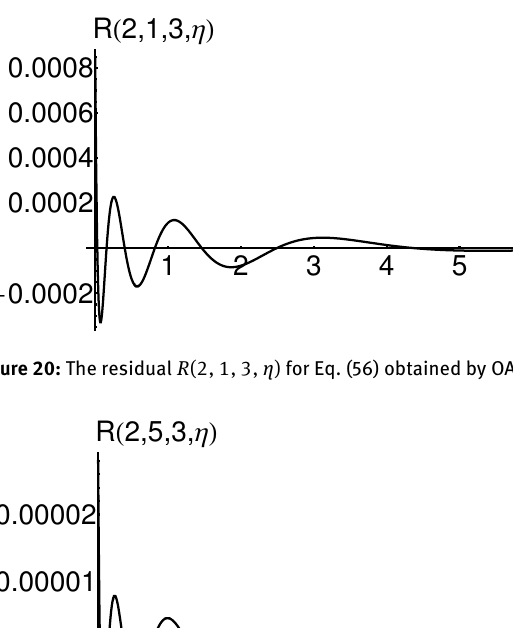
Figure 19: The residual R (2, 10, 0, η ) for Eq. (55) obtained by OAFM